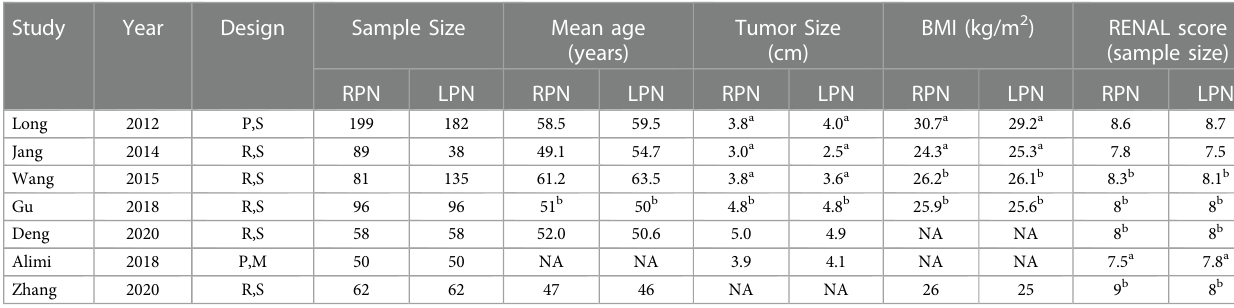
TABLE 3 Basic characteristics of the included studies.